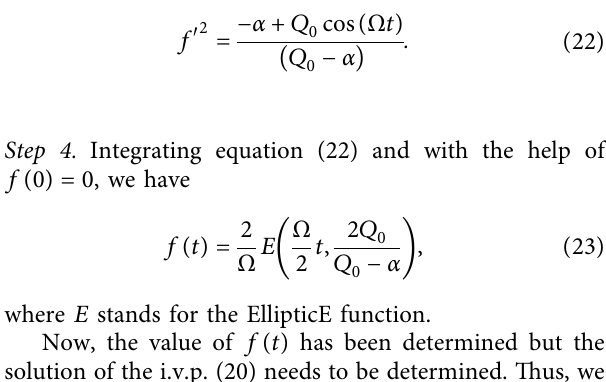
suitable (given in equation (15)) and κ optimal (given in (18)) is plotted )